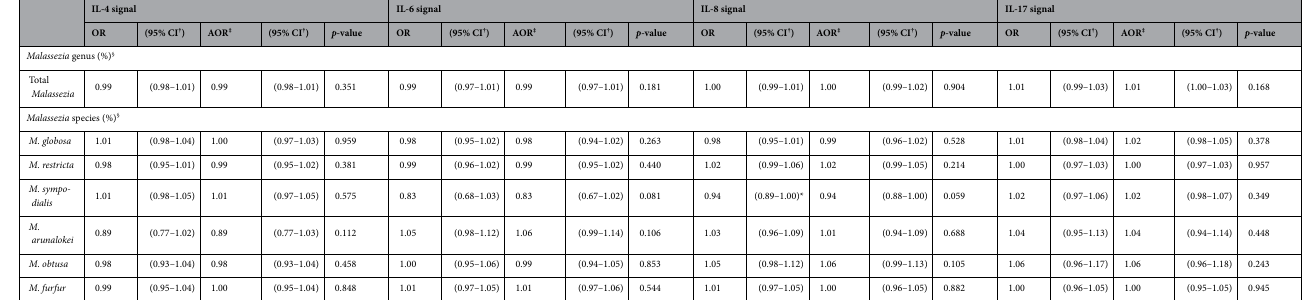
Table 5. Relationship of Malassezia with four inflammatory cytokine signals by multiple logistic regression analysis (n = 96). † CI confidence interval, ‡ AOR Adjusted Odds Ratio, Multiple logistic regression analysis was adjusted for the variables of family history of atopic dermatitis and birth season, § Percentage of total fungal populations was calculated, * p <